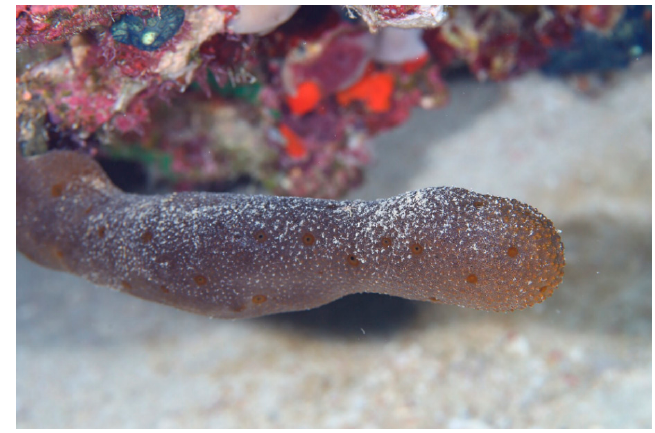
Figure 6. Underwater photograph of the Red Sea sponge Hyrtios erectus .